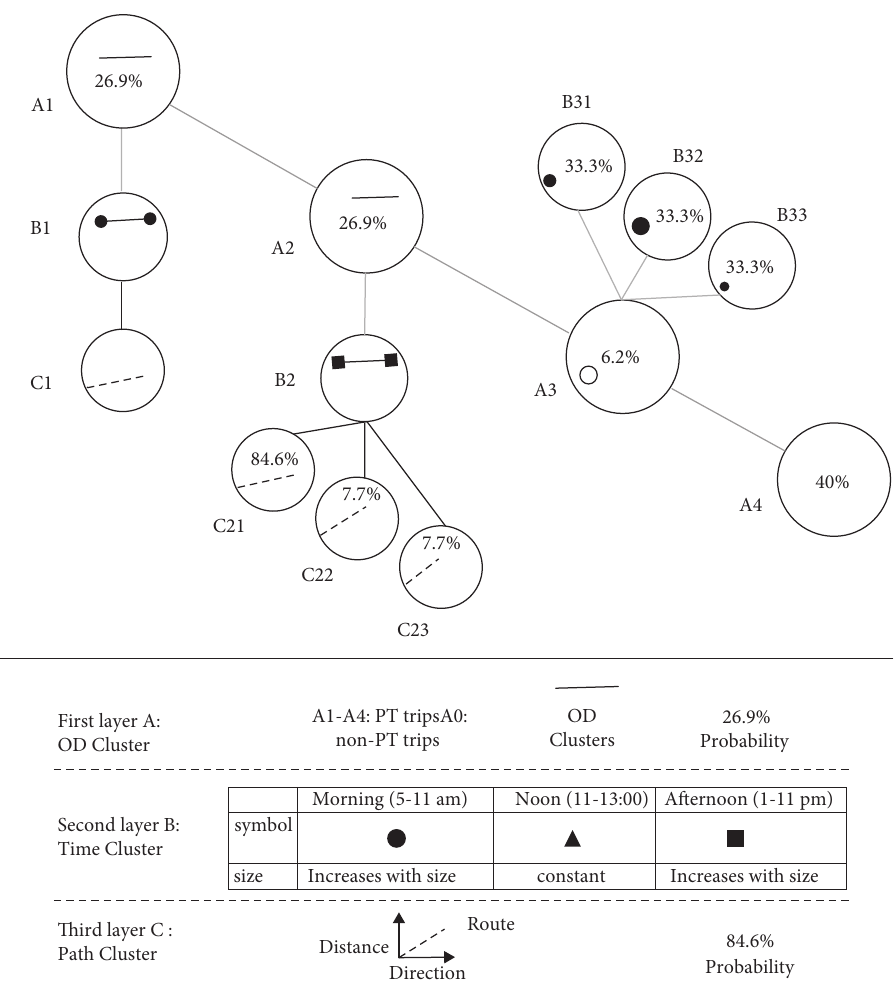
Figure 5: Travel knowledge graph of a PT passenger.